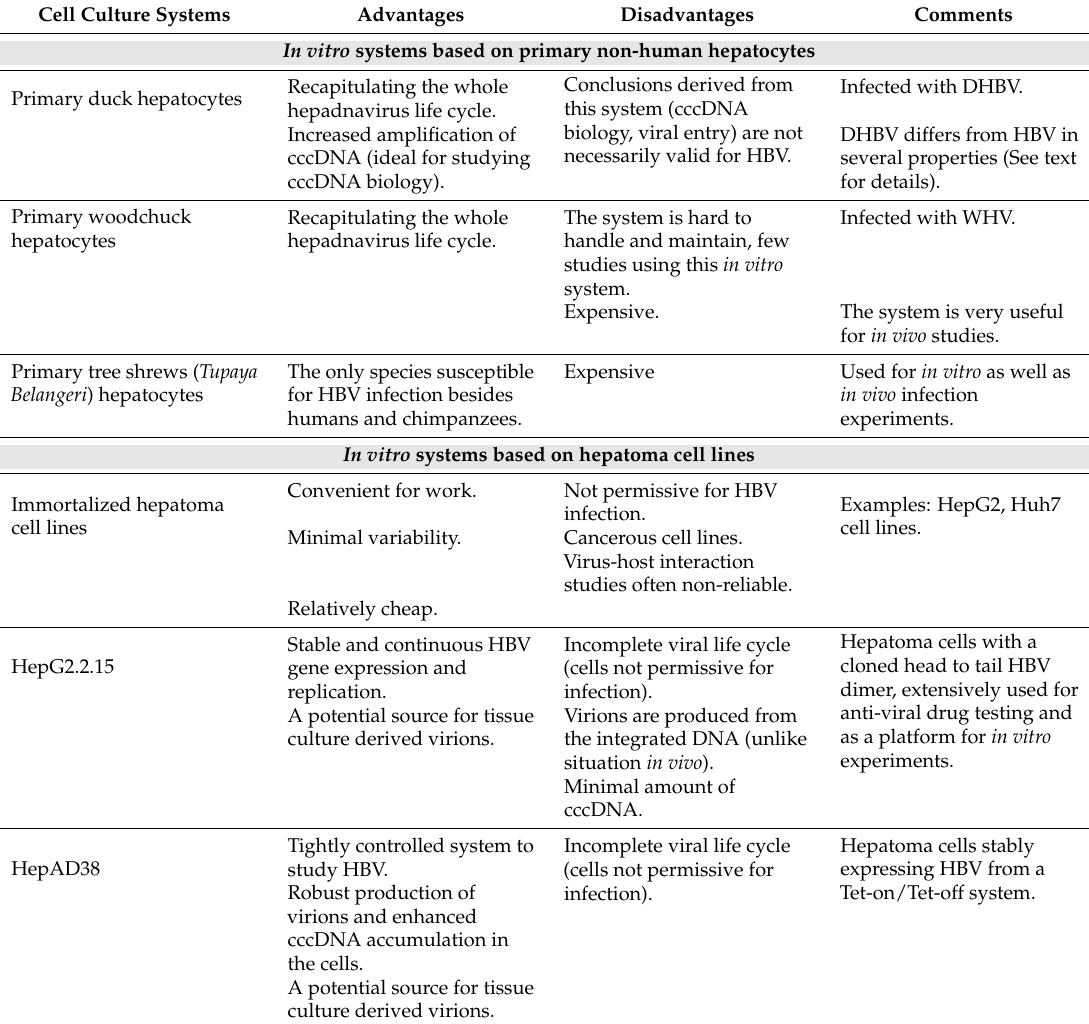
Table 1. A summary of the various in vitro systems for studying HBV